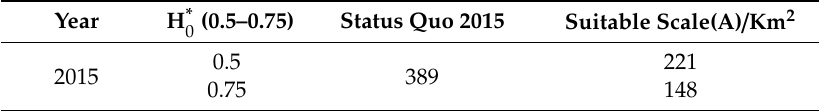
Table 6. Suitable oasis irrigation district scales / km 2